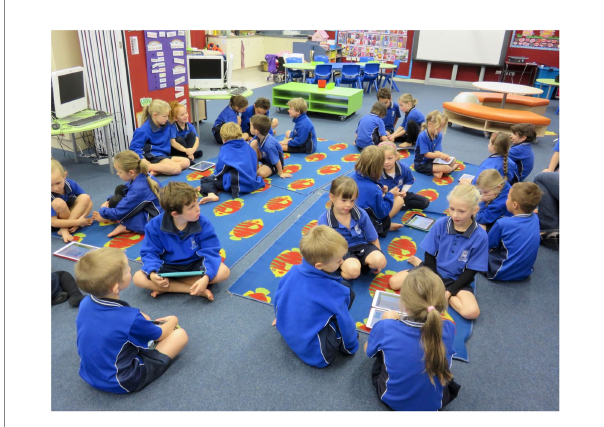
FIGURE 2 The class giving and receiving feedback on their Scratch coding.